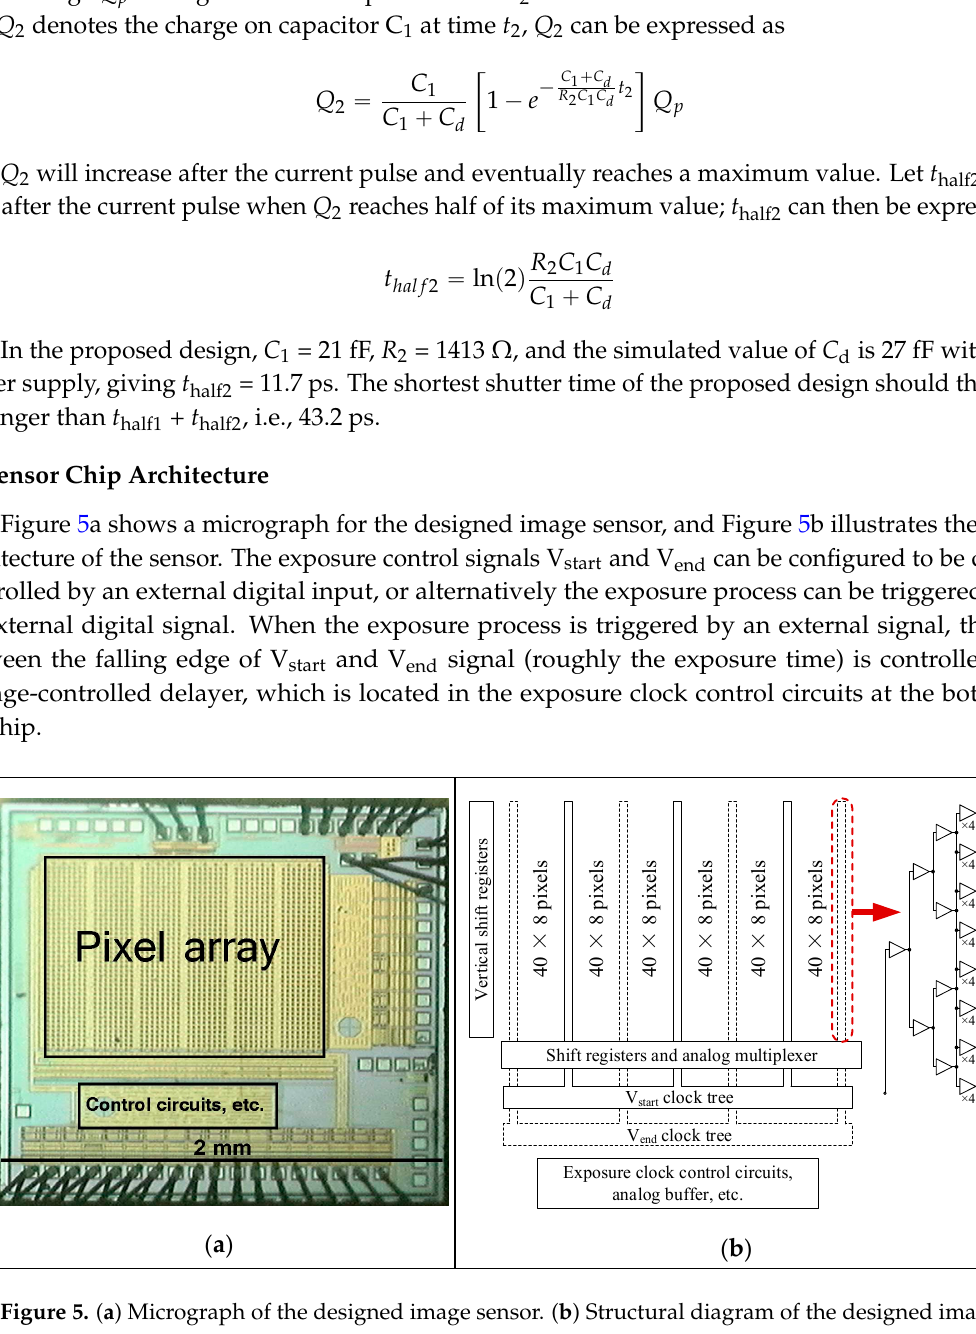
Figure 5. ( a ) Micrograph of the designed image sensor. ( b ) Structural diagram of the designed image sensor; simplified schematic of a single vertical component in the clock trees.